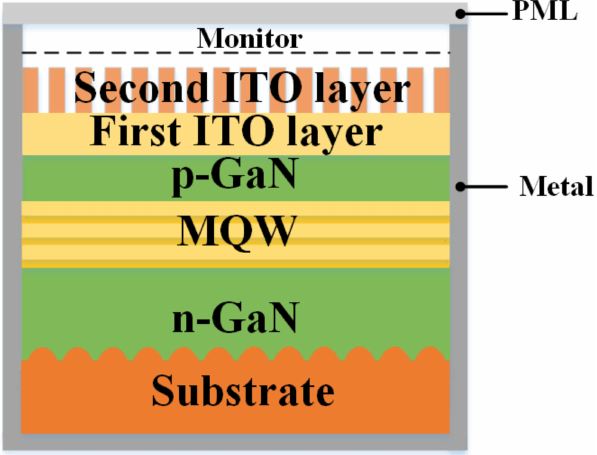
Figure 7. Schematic illustration of the FDTD simulation model for UV LED with a patterned double layer